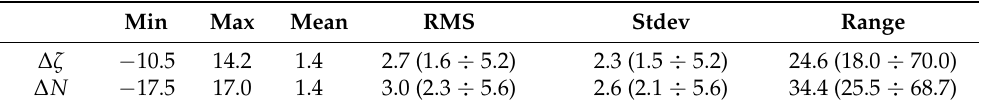
Table 3. Basic statistics of the differences ∆ ζ = ζ GGI − ζ m and ∆ N = N GGI − N m based on all 1 (cid:48) × 1 (cid:48) grids points (in centimeters). In brackets are the ranges of corresponding values obtained for methods participating in the Colorado geoid experiment (based on